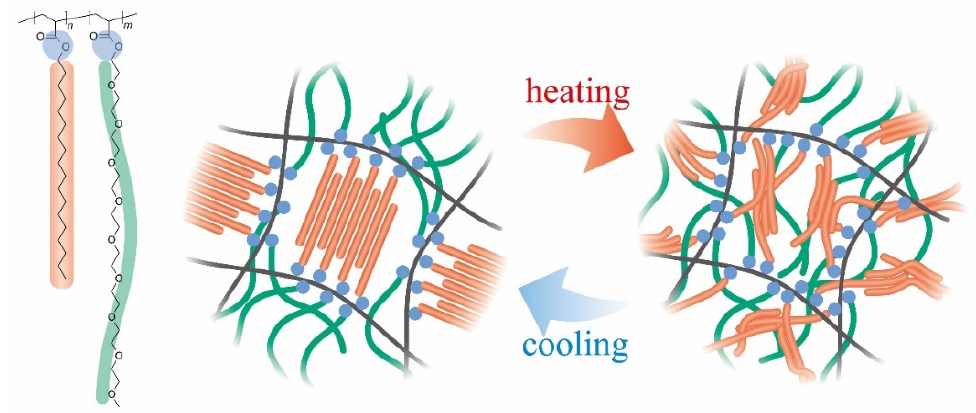
Figure 1. Chemical structure of poly(SA- co -MPGA) and an illustration of the crystalline-to-amorphous transition.